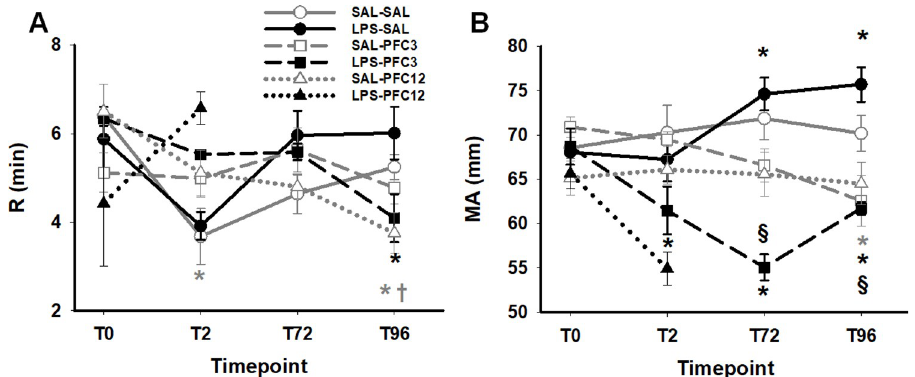
Fig 5. The combination of LPS and PFC caused faster clot initiation and decreased clot strength. A. Clot initiation is accelerated with PFC by 4 days. Both SAL-PFC12 and LPS-PFC3 are significantly decreased from BL levels ( � , p < .05); SAL-PFC12 is significantly different from SAL-SAL control (†, p < .05). B. Changes in clot strength over time are shown. Significant changes from BL for LPS groups are depicted by � (p < .05); significant differences between LPS-SAL and LPS-PFC3 at time pts are shown by § (p < .05). Comparing groups, there is a significant decline in TEG MA in LPS-PFC3 group compared to LPS-SAL group at T72 and T96 time points (p < 0.05). By RM ANOVA, the time effects were obscured by interaction with group: SAL-SAL, p = NS; LPS-SAL, MA increases with time; T0 v T72 and T96, p � 0.05; SAL-PFC: MA drops @ T96, p � 0.05; LPS-PFC: T0 v all others, p � 0.05 with a recovery at T96, (p � 0.05 compared to T72); SAL-PFC: no significant change, p = NS. In group effects, LPS-SAL was significantly different from LPS-PFC3 and SAL-PFC3 was significantly different from LPS-PFC3.